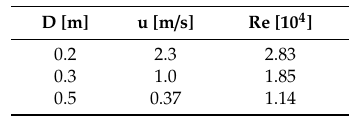
Table 4. Reynolds numbers evaluated for each couple of diameter and inlet velocity